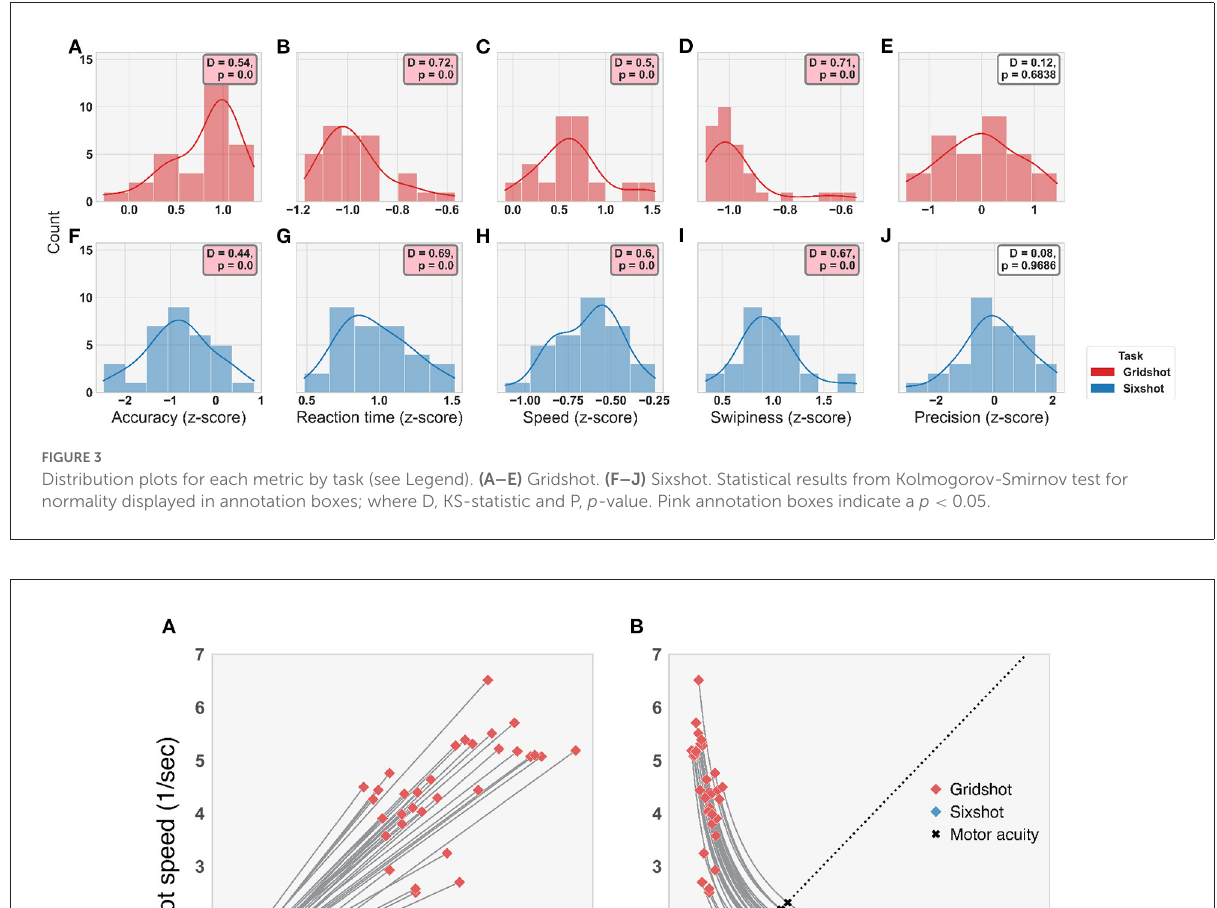
followed the expected pattern in behavior: faster and more variable in Gridshot compared to Sixshot. This demonstrates